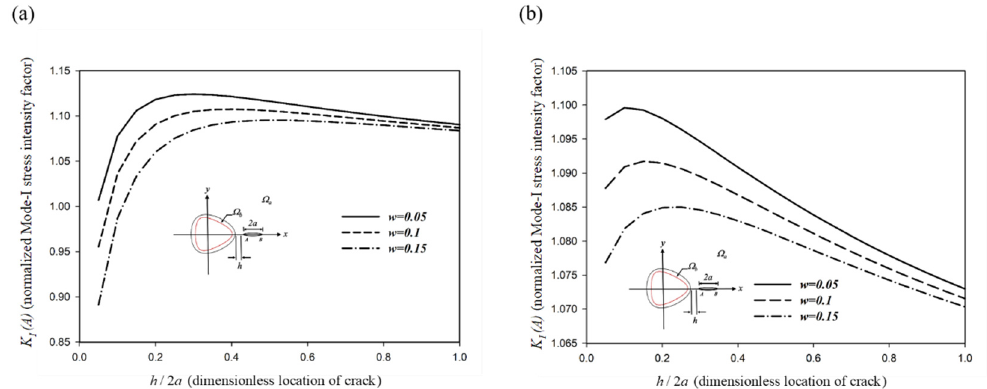
Figure 10. SIFs with different shape factors of an approximately triangular hole with an inclusion layer ( a ) at Tip A ( b ) at Tip B ( r = 1.05, G